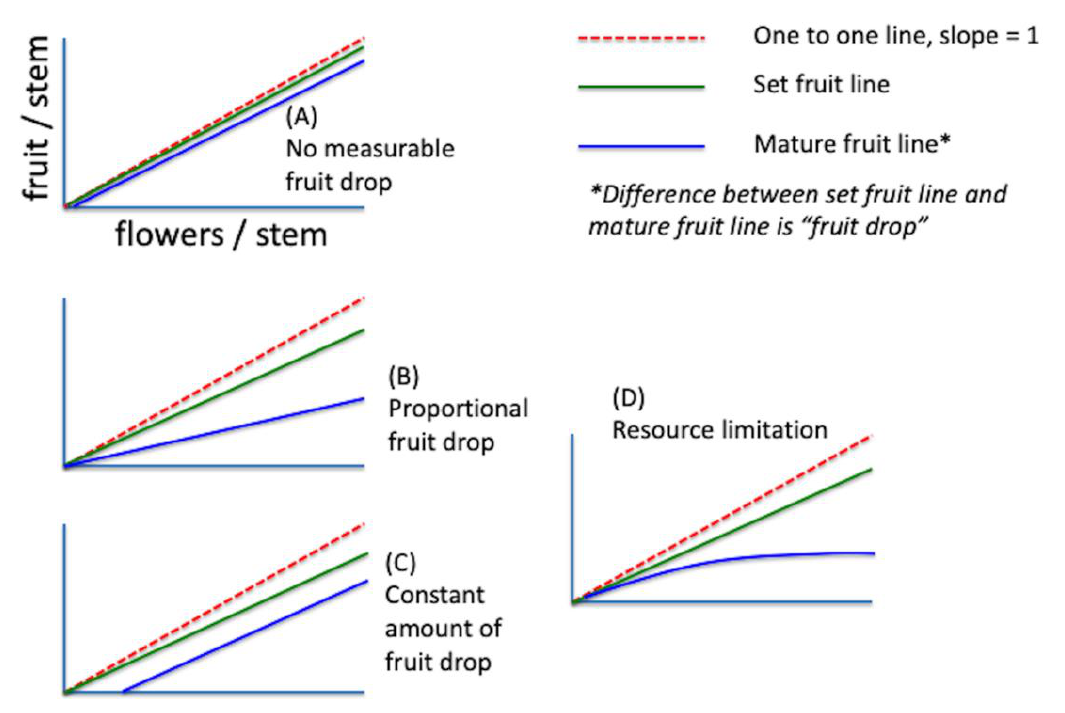
Figure 2. Conceptual model of the four expectations of fruit drop tested with field data from two clones (1977): ( A ) no measurable fruit drop; ( B ) proportional fruit drop; ( C ) constant amount of fruit drop; and ( D ) resource limitation. An explanation of the four expectations is in the main text.